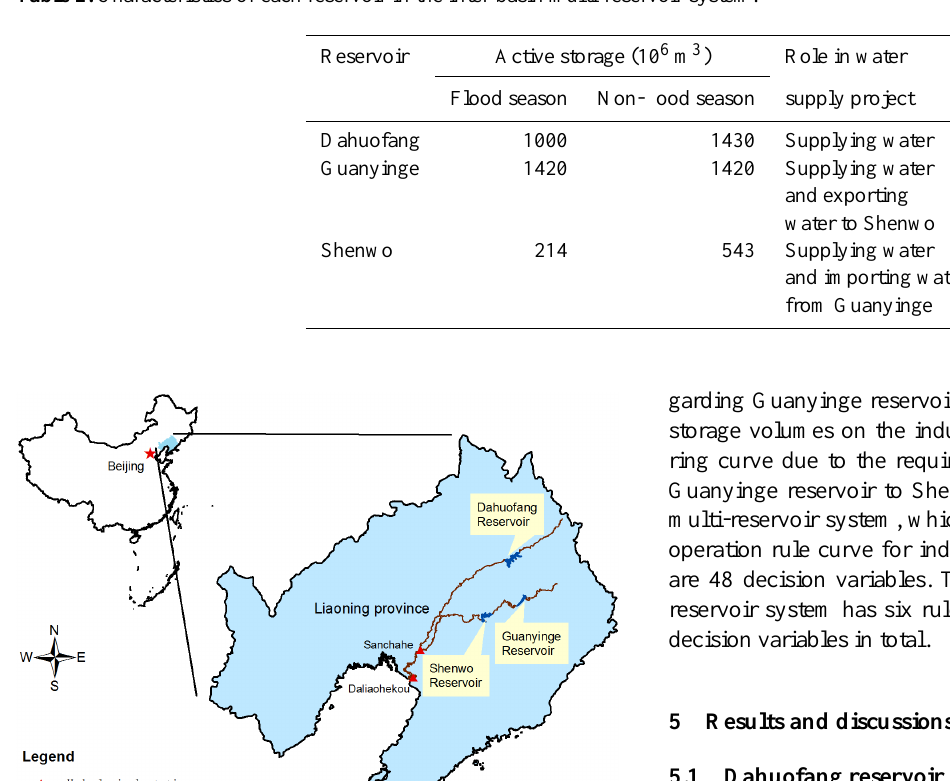
Table 2. Characteristics of each reservoir in the inter-basin multi-reservoir system.